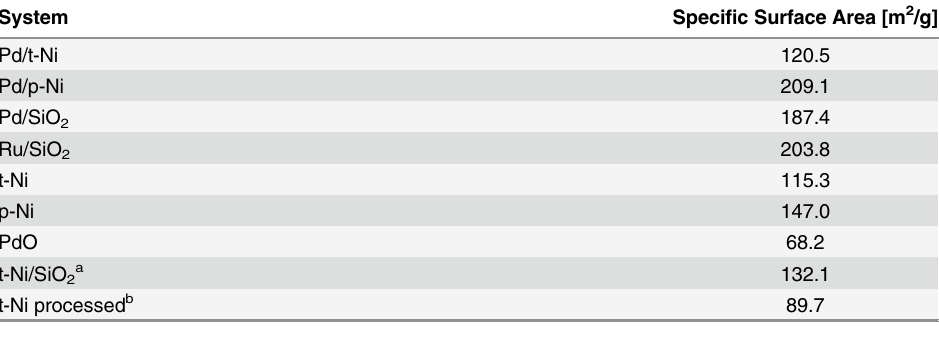
Table 1. Specific surface area of the catalysts, precursors and reference materials